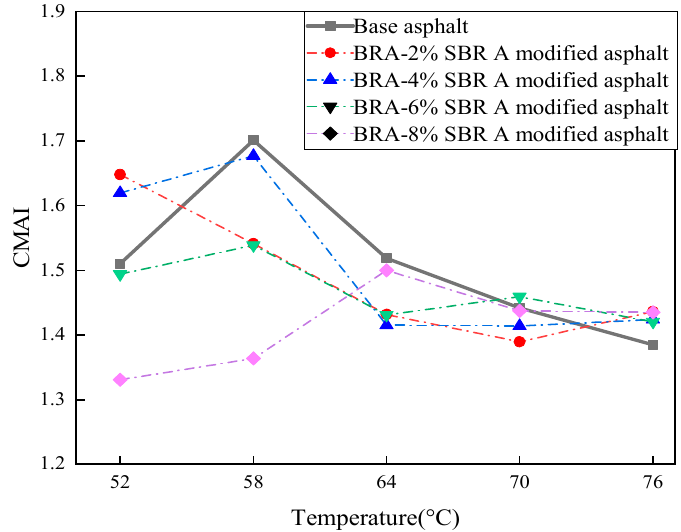
Figure 6. The complex modulus aging index (CMAI) of base asphalt and BRA-SBR A modified asphalt.